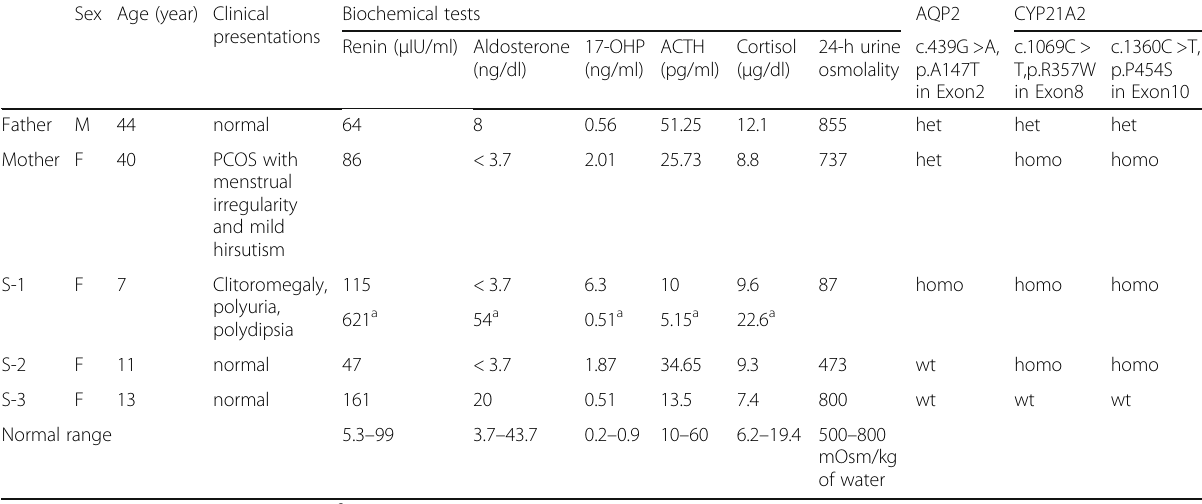
Table 1 Clinical and genetic analysis of a patient with concomitant 21-hydroxylase deficiency and nephrogenic diabetes insipidus Sex Age (year) Clinical Biochemical presentations